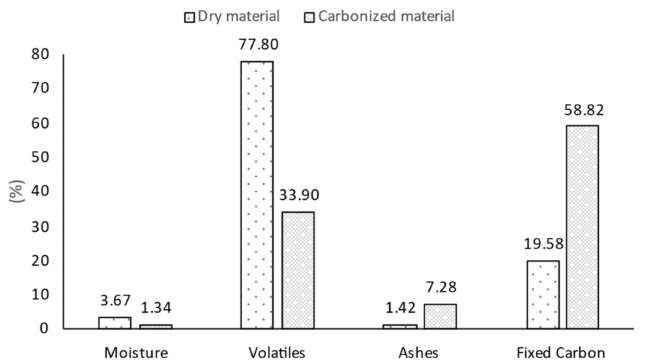
Figure 3. Evolution of moisture, volatiles, ashes and fixed carbon contents after carbonization of vine